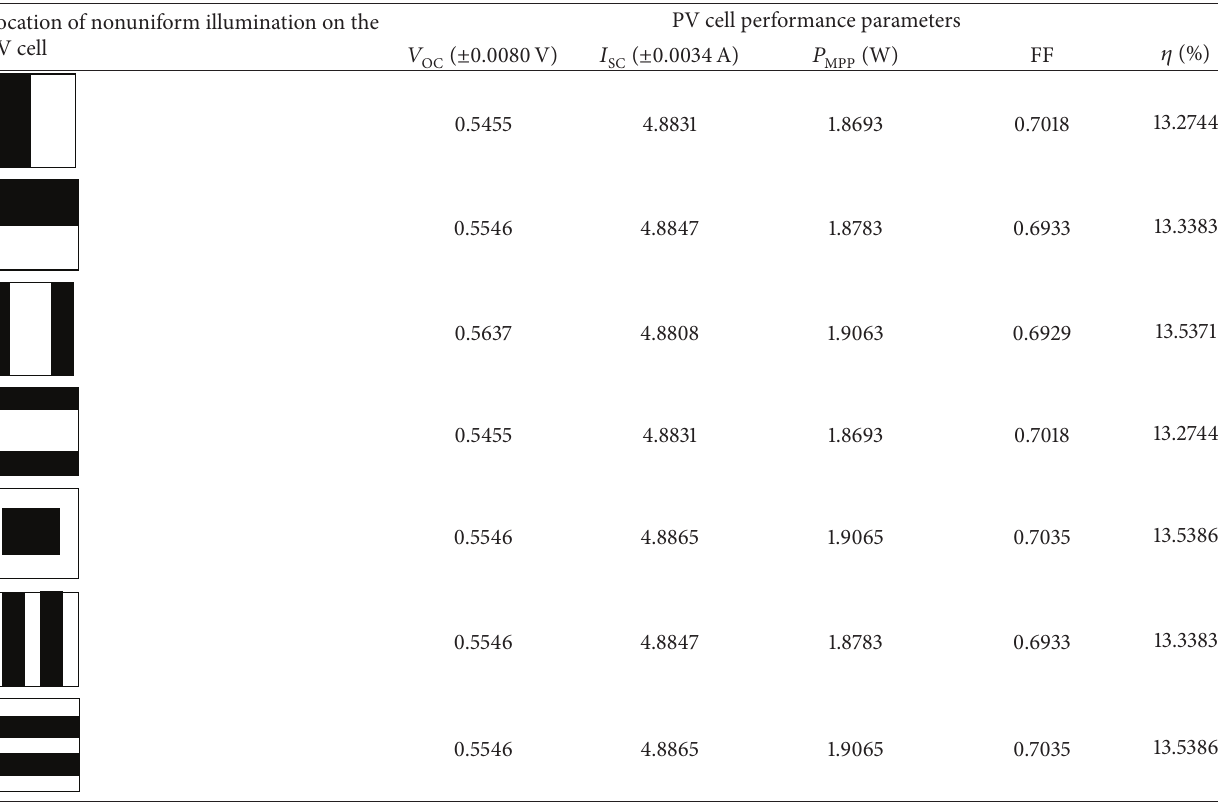
Table 7: The effect of nonuniform illumination locations on the PV cell performance parameters. In each case, the level of nonuniform illumination was 50% of the total cell area.